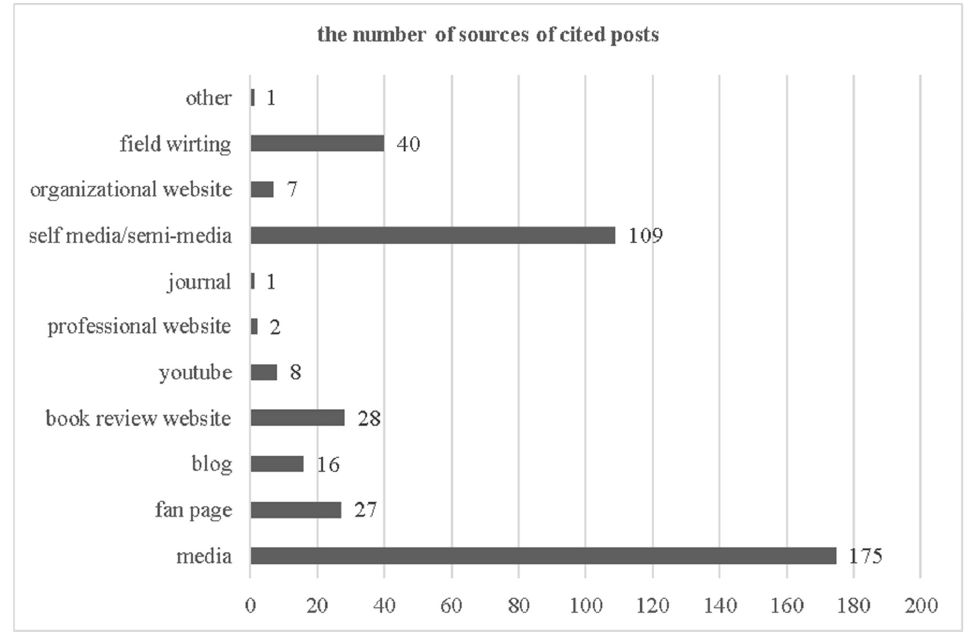
Figure 3. The content sources of 414 quoted posts.